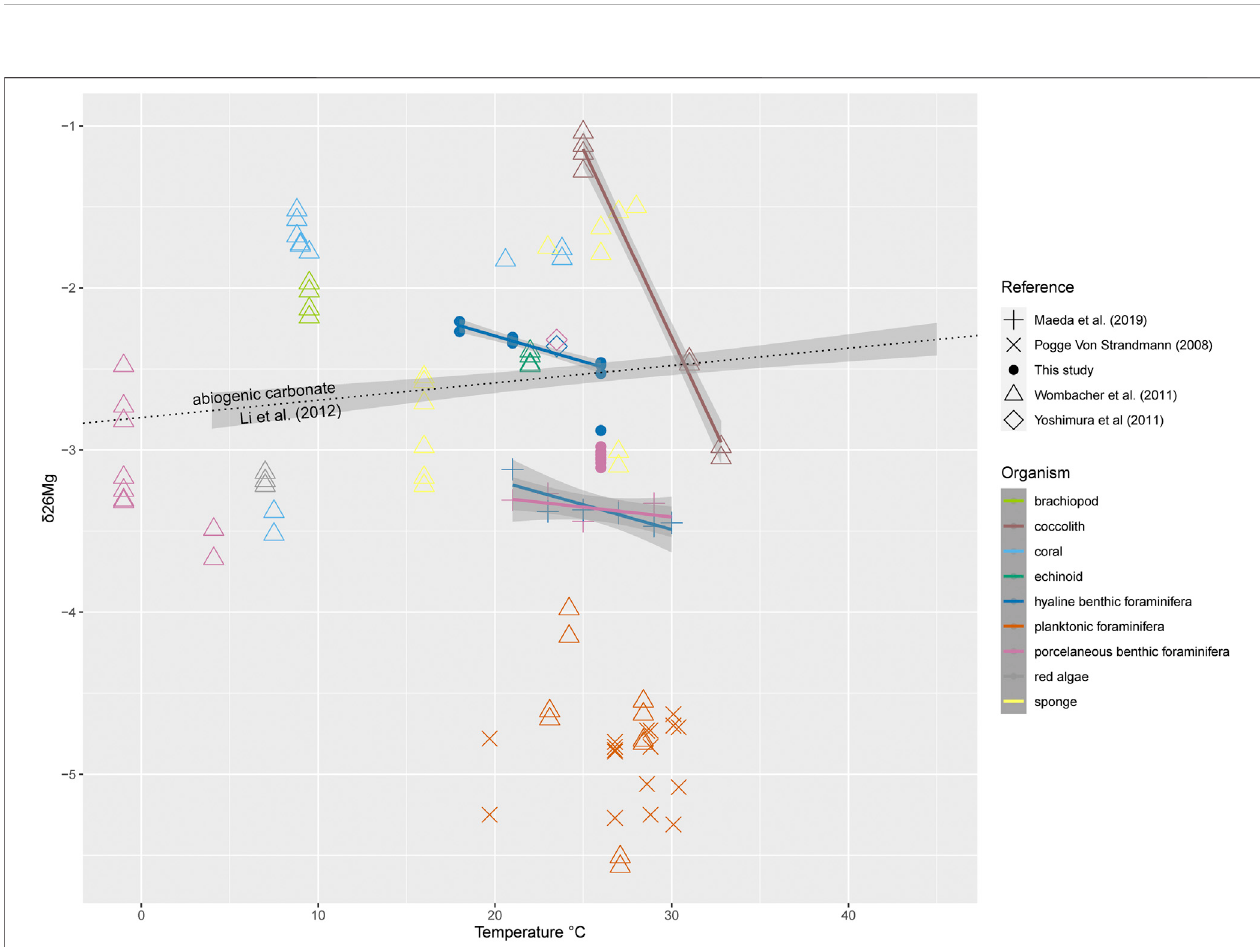
Frontiers in Earth Science |